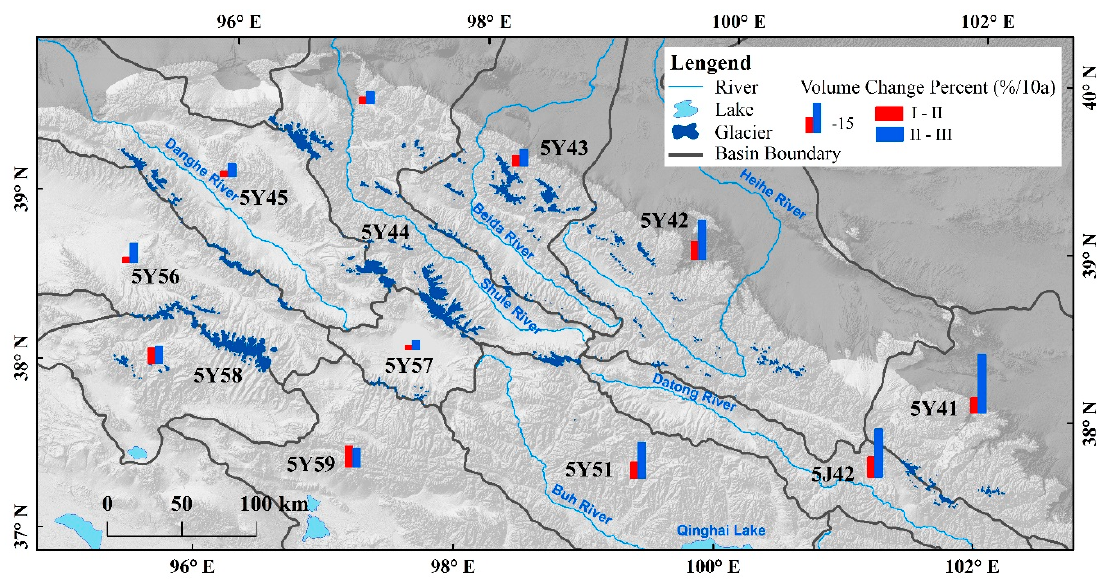
Figure 11. Volume change percent of glaciers in different basins from three inventories.